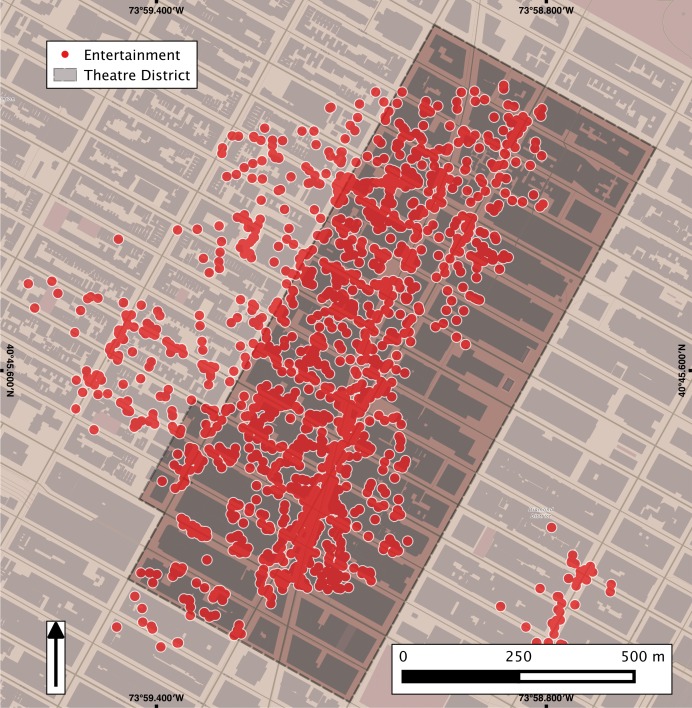
Depiction of spatially significant clusters and the Theatre Sub District, NYC.The spatial concentration of entertainment tweet clusters (red dots) contained within, and nearby, the Theatre Sub District (yellow polygon) show the alignment of platial expressions with local affordances (i.e. theatres around Broadway). We observe the dynamics of platial expressions with spaces adjacent to the official boundary being reconstituted with entertainment expressions.